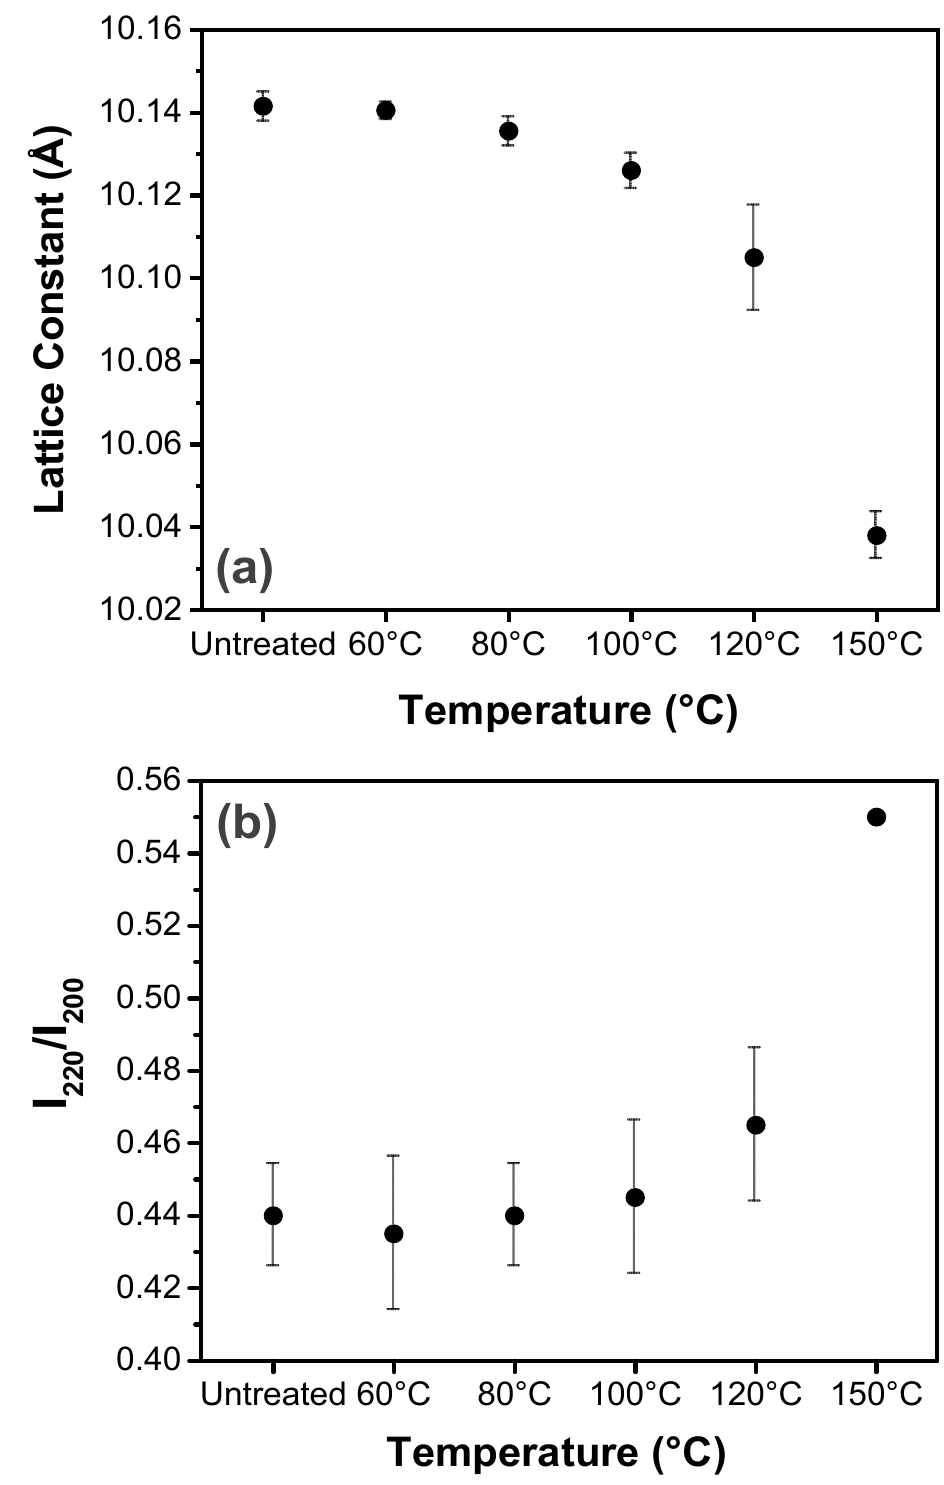
Figure 4. ( a ) Average lattice constant of the CuHCF powder as a function of the temperature employed during the thermal treatment, ( b ) average variation in X-ray-diffraction-intensity ratio between 220 and 200 planes (I 220 /I 200 ) of the CuHCF powder as a function of the temperature employed during the thermal treatment. The mean values and standard deviations were estimated by comparing at least two different samples resulting from two different thermally treated CuHCF powders.